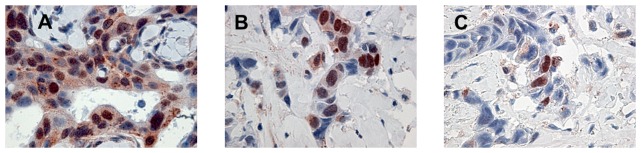
Nuclear immunoreactivity of HIF-1α in representative tissue samples of breast cancer.(A) and (B) show nuclear HIF-1α overexpression in BRCA1-2 carrier and BRCAX breast cancers respectively; (C) shows low nuclear HIF-1α expression in sporadic breast cancers.